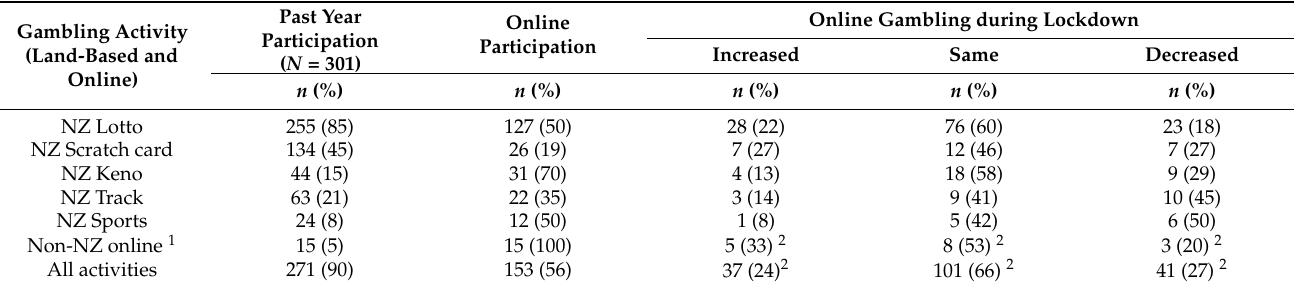
Table 4. Participation in online gambling during lockdown.